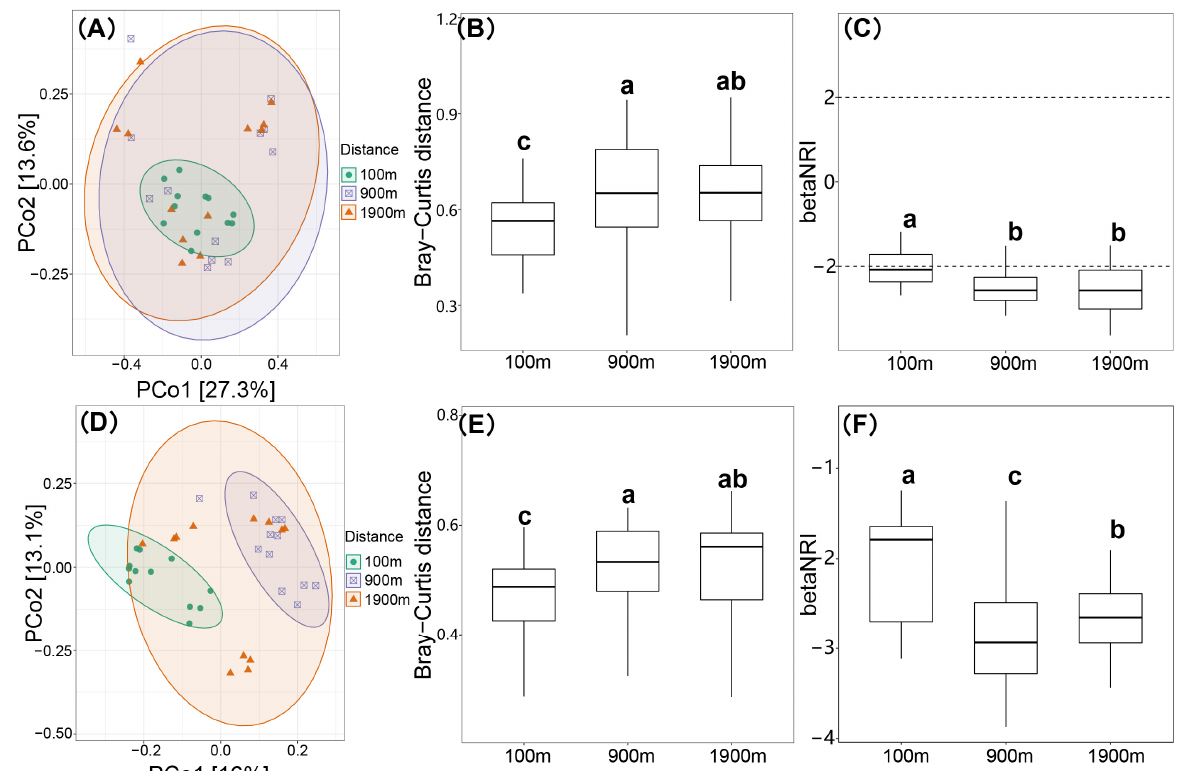
Figure 3. β diversity analysis of soil AMF and soil fungal communities. ( A ): Soil AMF Principal Co-ordinates Analysis (PCoA), ( B ): AMF Bray–Curtis distance, ( C ): AMF β -Net Relatedness Index (betaNRI), ( D ): Soil fungal PCoA, ( E ): Soil fungal Bray–Curtis distance, ( F ): Soil fungal betaNRI. Significantly different are bars followed by lowercase letters ( p <